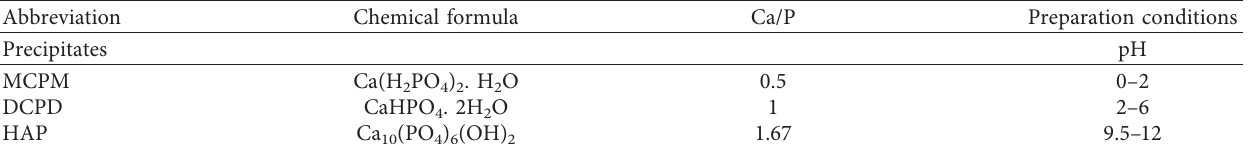
Table 1: pH precipitation range of some calcium phosphates [11–14].